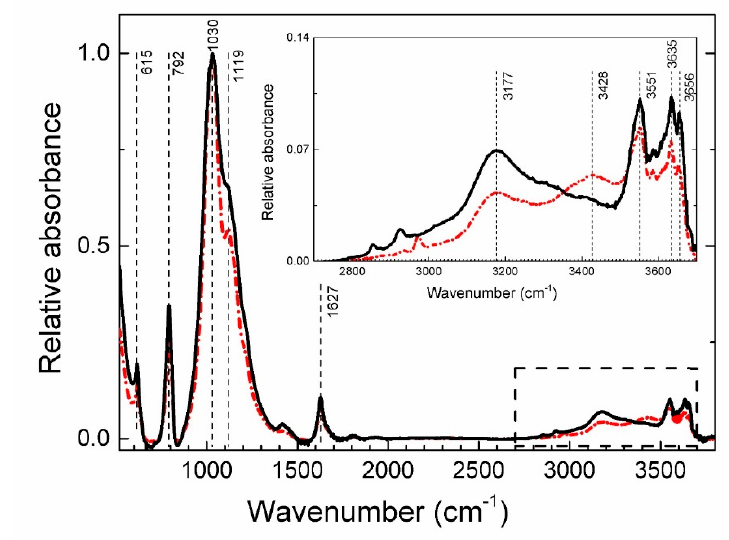
Figure 11. Infrared absorption spectra of fedorite; red dashed curve—sample Gav-43, black solid curve—sample Irk-53.